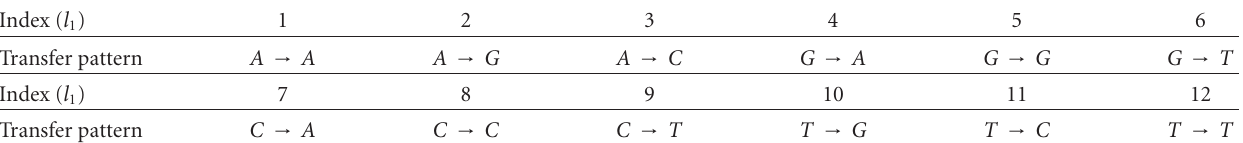
Table 6: An example of chemical mutagens and their corresponding transfer patterns in deterministic mutations.